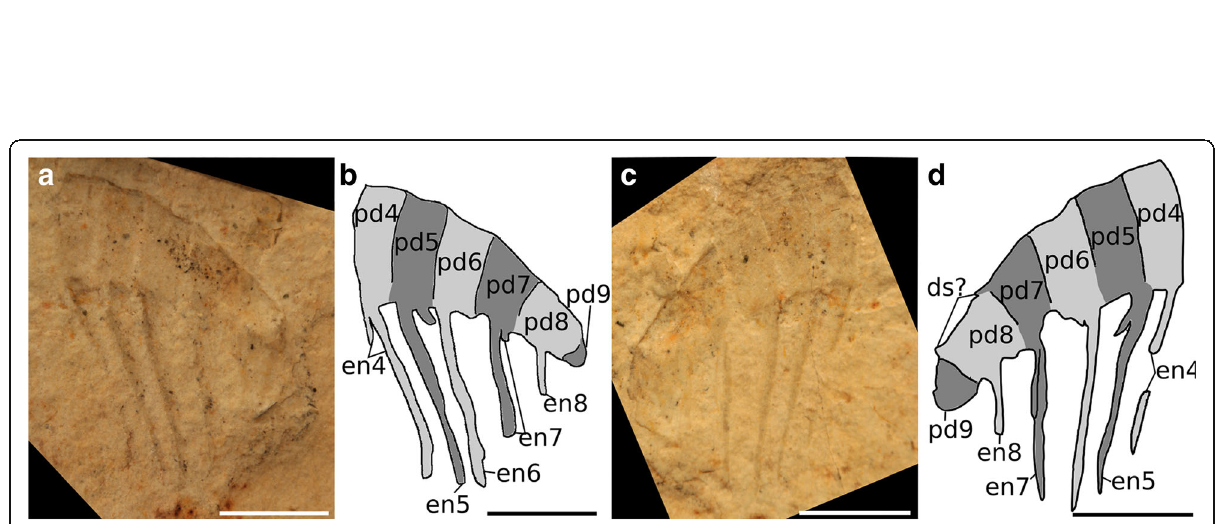
Fig. 5 Ursulinacaris grallae? partial appendage from the Jangle Limestone Member, Carrara Formation, Nevada, USA. KUMIP 492945. a and b part. c and d counterpart. Abbreviations: en, endite; pd., podomere. Scale bars = 5